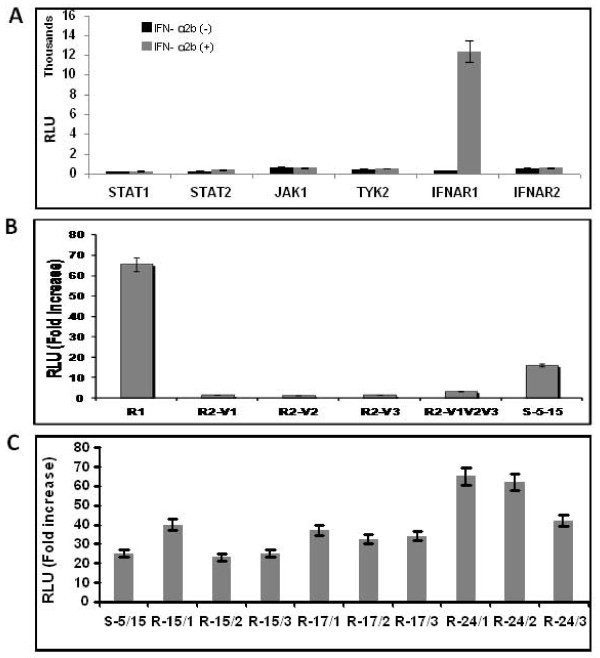
IFNAR1 protein expression complements the ISRE-firefly luciferase promoter activation in the resistant Huh-7 cells. The cured resistant Huh-7 cell line (R-17/3) was co-transfected with ISRE-firefly luciferase plasmid along with each expression plasmid by FuGene6 transfection reagent. The pRL-TK plasmid was used as a transfection control. After this step, cells were treated with IFN-α (1000 IU/ml). After 24 hours, cells were lyzed and luciferase activity was measured. The graphs represent a relative to control luciferase activity. (A) The activation of ISRE promoter by IFN-α in R-17/3 cells expressing different proteins of Jak-Stat signaling expressed as relative luciferase units (RLU) between IFN-α treated and untreated. Expression of wild type full-length IFNAR1 protein is able to induce the ISRE-Luciferase activity. (B) The induction of ISRE-luciferase activity in the R-17/3 cells by IFN-α in the presence of three different variants of IFNAR2 and wild type IFNAR1 was depicted as fold increase as compared to untreated cells. (C) IFN-α induces the ISRE-Firefly luciferase activity (fold increase) in all nine IFN-α resistant Huh-7 cell lines when they were co-transfected with the wild type IFNAR1 plasmid.